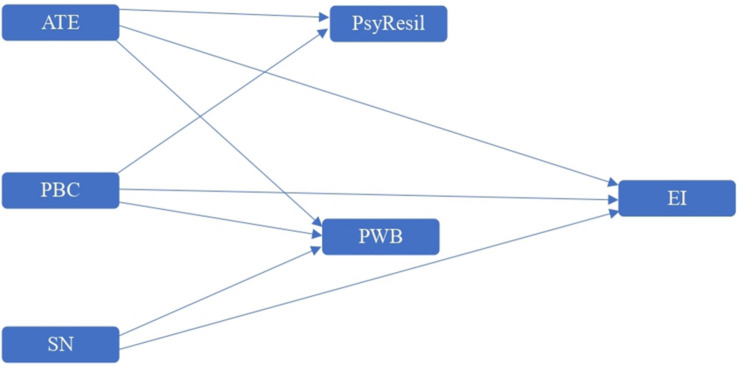
Structural model.